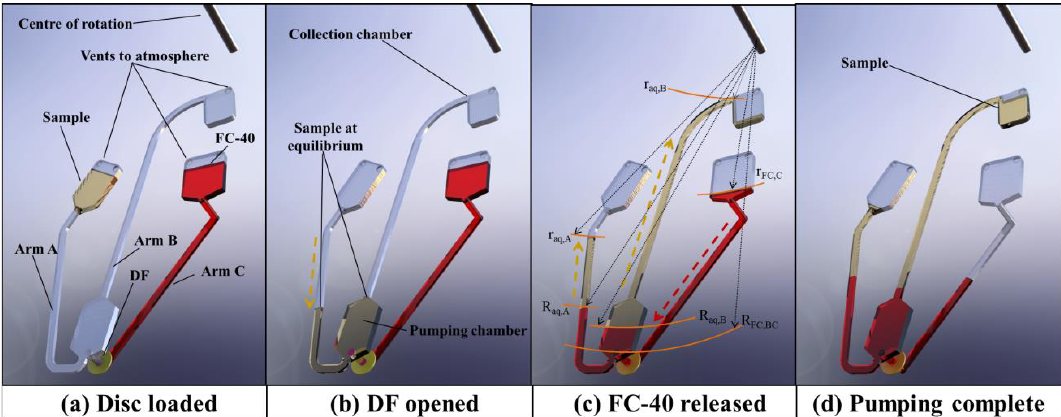
Figure 1. Basic pumping concept. ( a ) Disc loaded at a lower spin rate. The FC-40 (red) is restrained by a DF table. The aqueous sample (yellow) is stopped by a capillary valve. ( b ) Upon elevation of the spin rate beyond its burst frequency, the sample is transferred into the pumping chamber through arm A. The DF is wetted and opened. ( c ) The high-density FC-40 is centrifugally pumped (arm C) to flow underneath and then lift the aqueous layer. The sample is then displaced radially inwards (arm B) into the collection chamber. ( d ) Pumping is completed when the system reaches hydrostatic equilibrium.